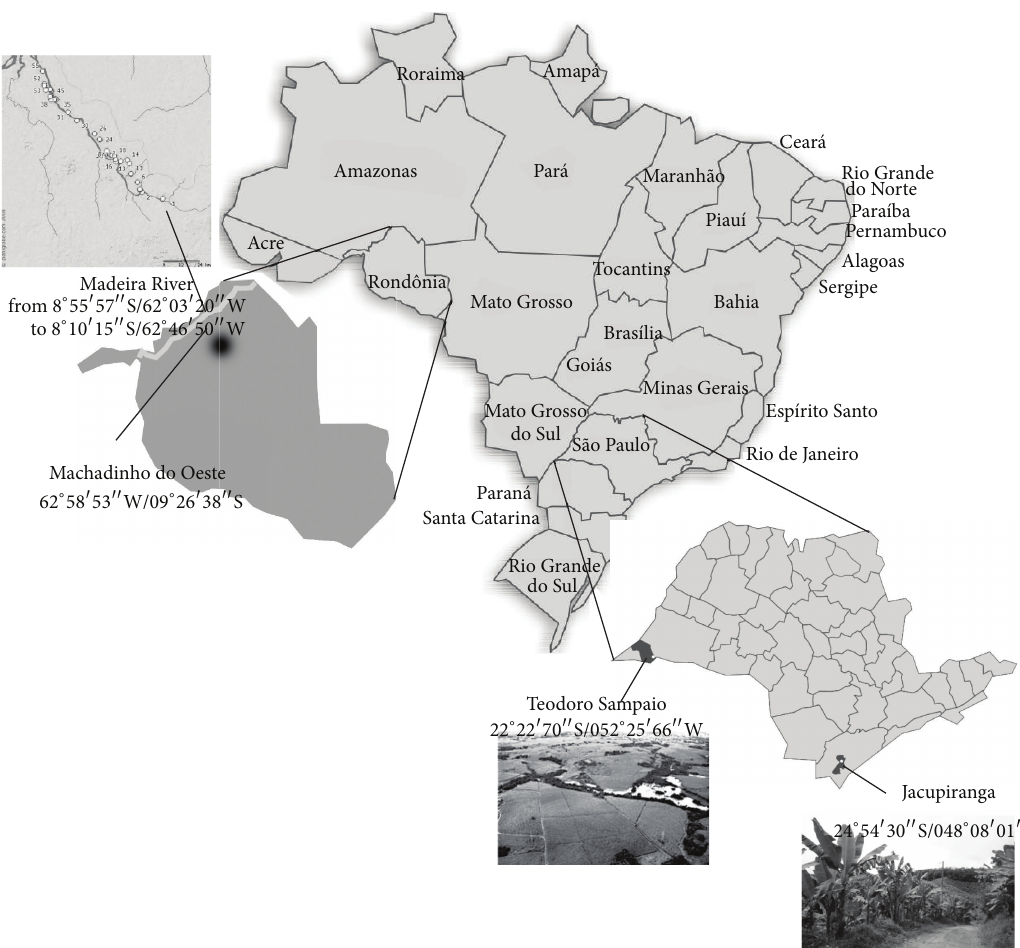
Figure 1: Map of Brazil showing the four study sites: the city of Jacupiranga (RV) and Teodoro Sampaio (PP) in S˜ao Paulo state in the subtropical region and Machadinho do Oeste city and the Machado river region Rondˆonia state in the tropical